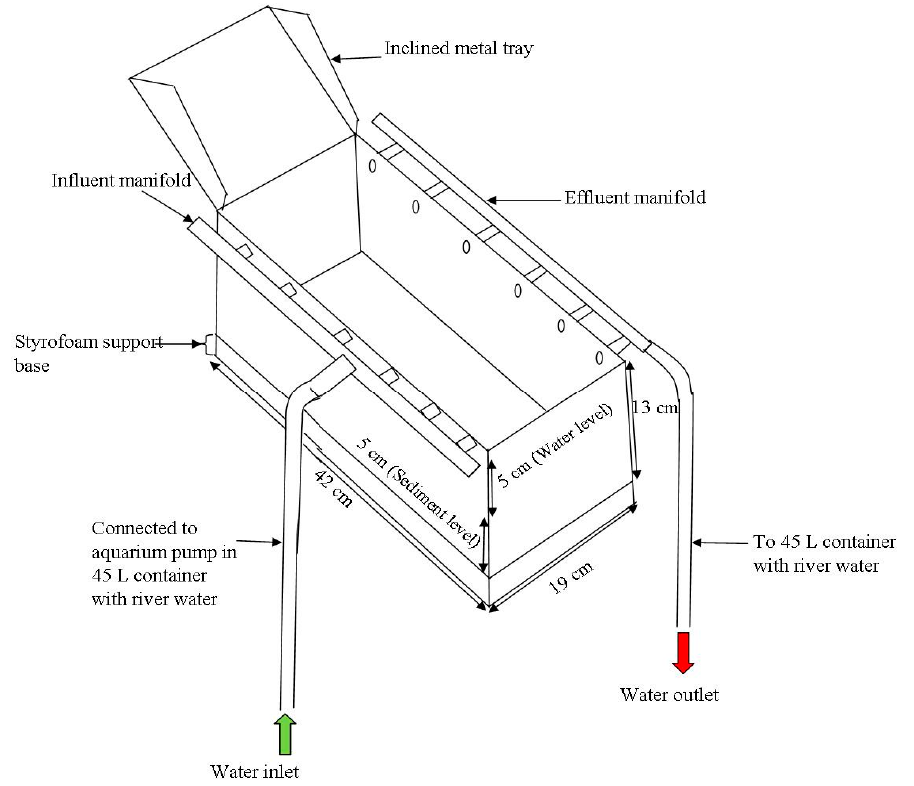
Figure 2. Schematic representation of sediment chambers used for the laboratory resuspension experiments (Figure modified from Abia et al. [38]).